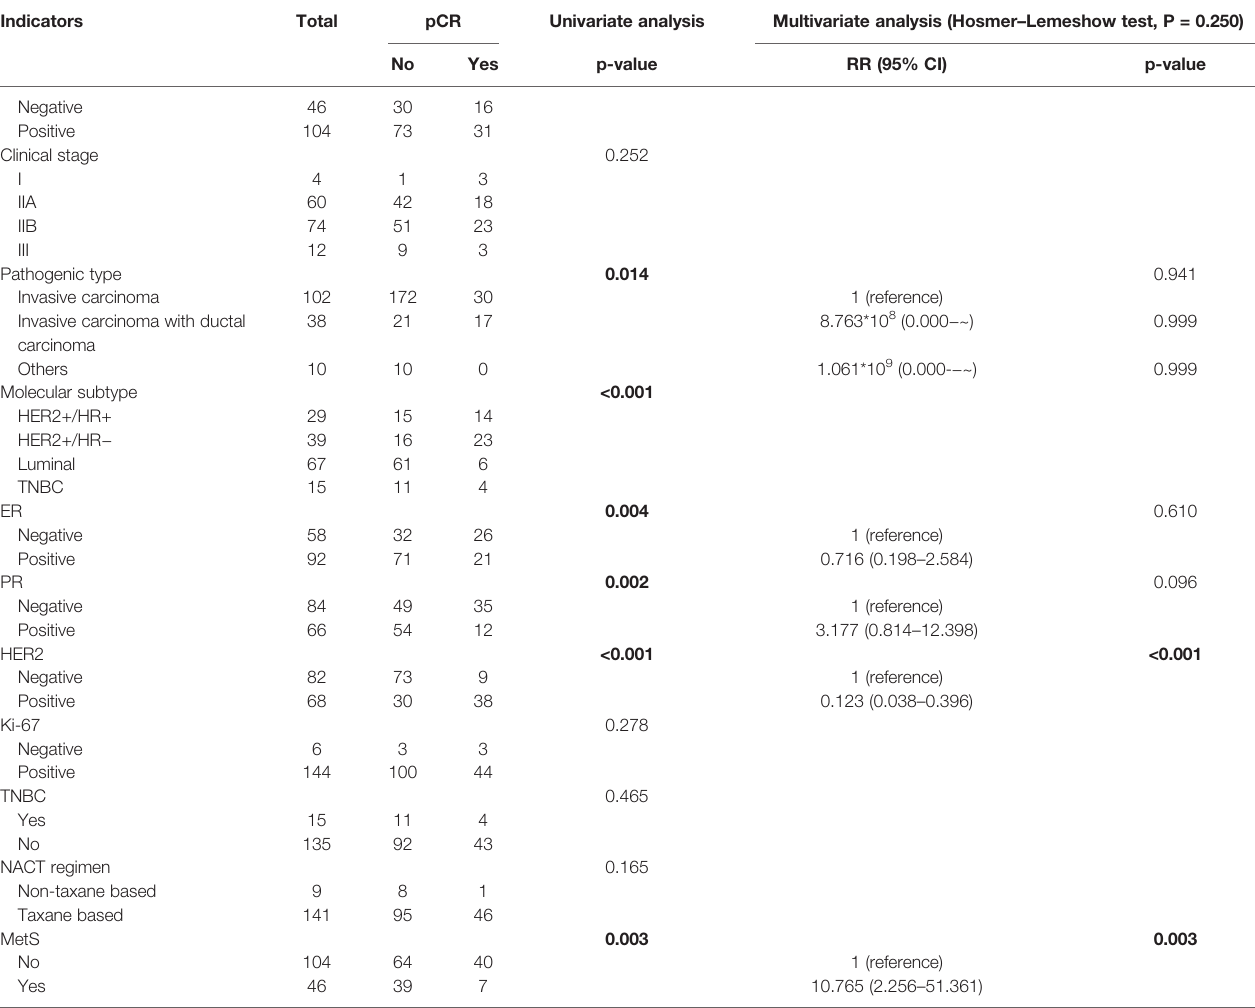
Figure 1 ). Multivariate analysis did not fi nd indicators related to clinical and pathological response ( Supplementary Tables 9, 10 ).